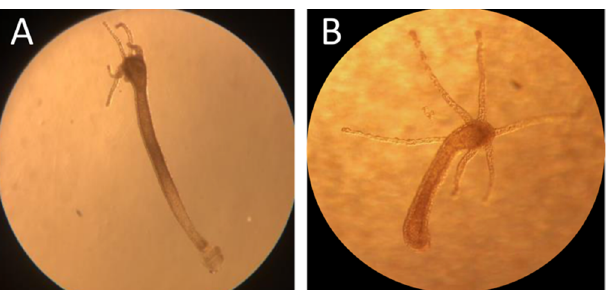
Figure 3. Regeneration of H. vulgaris columns exposed to AgNPcitLcys ( A ) and AgNO 3 ( B ) for 7 days at 1000 μ g/L and 100 μ g/L, respectively.